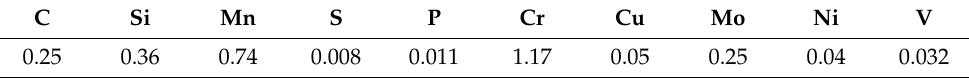
Table 1. Main chemical compositions of the EA4T steel (wt. %).